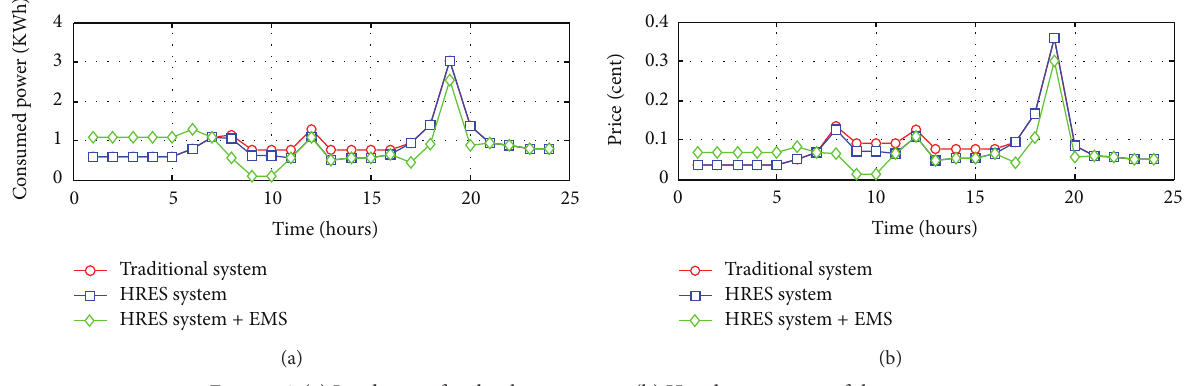
Figure 6: (a) Load curve for the three systems. (b) Hourly cost curve of three